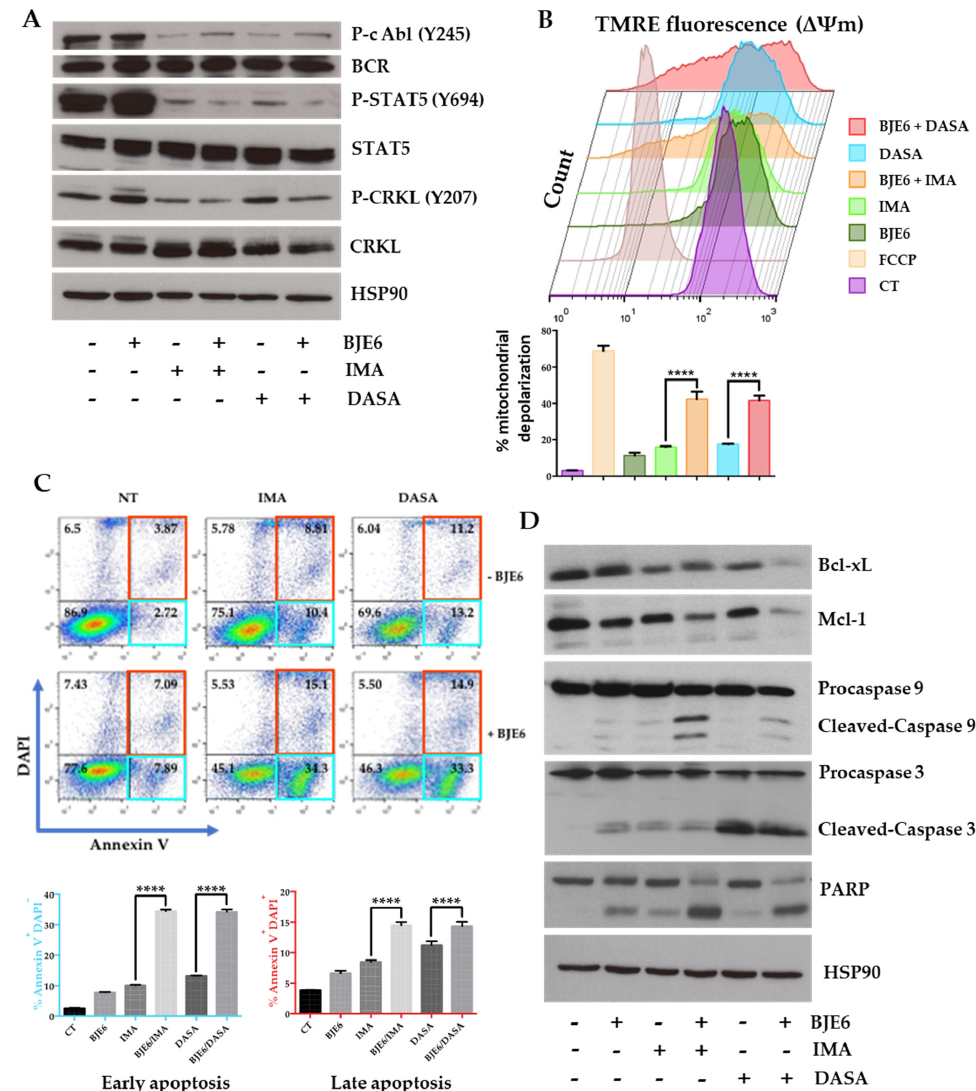
Figure 4. Combinations of PKC δ and BCR-ABL inhibitors induced apoptosis events in K562 cells. ( A ) K562 cells were stimulated or not with 0.5 µM BJE6, 1 µM IMA, 2 nM DASA, or combinations for 15 min. Cell lysates were analyzed by immunoblotting for indicated proteins. ( B ) K562 cells were stimulated or not with 0.5 µM BJE6, 1 µM IMA, 2 nM DASA, or combinations for 24 h. After 15 min of tetramethylrhodamine ethyl ester perchlorate (TMRE) staining (200 nM), 10 5 cells were analyzed by flow cytometry (upper panel). Quantification of mitochondrial depolarization expressed as % of cells that lost ΔΨ m. **** p < 0.0001, 2-way ANOVA (lower panel). ( C ) K562 cells were stimulated or not with 0.5 µM BJE6 in combination or not with 1 µM IMA or 2 nM DASA for 24 h. Cytometric analysis after Annexin V/DAPI labelling (left panel). Histograms for Annexin V + DAPI + cells (top-right panel) and Annexin V + DAPI-cells (bottom-right panel). **** p < 0.0001, 2-way ANOVA. ( D ) K562 cells were stimulated or not with 0.5 µM BJE6, 1 µM IMA, 2 nM DASA, or combinations for 24 h. Cell lysates were analyzed by immunoblotting for indicated proteins.